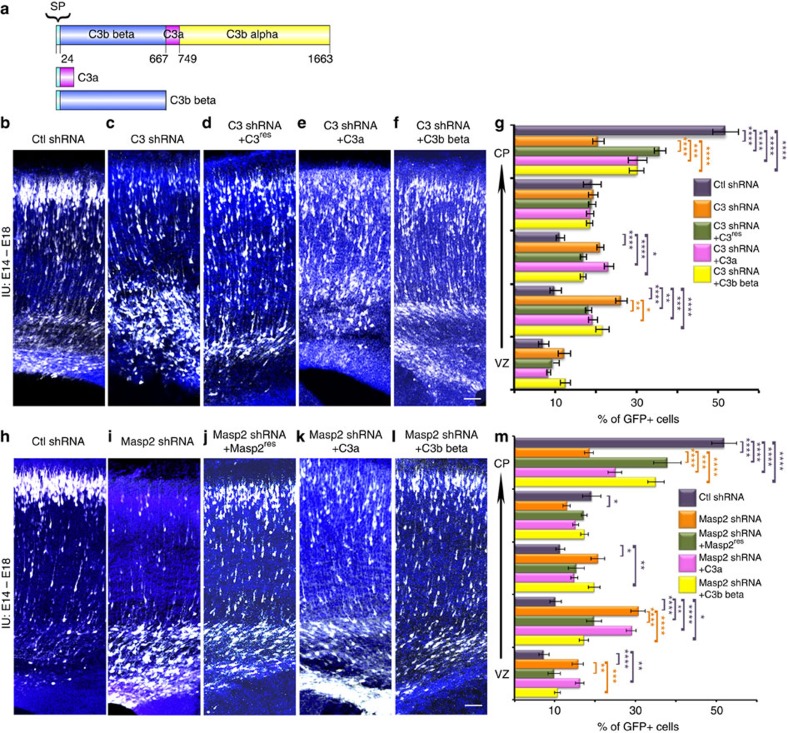
C3 cleavage products can rescue upstream migration deficits.(a) Schematic presentation of C3 cleavage (top) and the two peptides used in this study, C3a with an attached signal peptide (SP) and C3b beta. (b–g) C3 knockdown impairs neuronal migration and can be rescued in part by addition of either C3res, or C3a, or C3b beta. Brains were electroporated in utero (E14–E18) with control shRNA (b, n=4), C3 shRNA alone (c, n=5), or in combination with C3 resistant to the shRNA (d, n=3), C3a (e, n=3) or C3b beta (f, n=4). The distribution of neurons along the cortex is shown in five bins (from the VZ to the CP) for all the treatments (g). All the treatments were compared to control shRNA (the statistical significance is shown in violet) and to C3 shRNA (the statistical significance is shown in orange). (h–m) Masp2 knockdown impairs neuronal migration via the complement pathway. Brains were electroporated in utero (E14–E18) with control shRNA (h, n=4), Masp2 shRNA alone (i, n=4), or in combination with Masp2 resistant to the shRNA (j, n=3), C3a (k, n=4) or C3b beta (l, n=4). Quantification of the distribution of neurons across the cortex is shown for all the treatments (m). All the treatments were compared to control shRNA (the statistical significance is shown in violet) and to C3 shRNA (the statistical significance is shown in orange). The scale bars are 50 μm. *P<0.05; **P<0.01; ***P<0.001, ****P<0.0001, histograms present means±s.e.m.